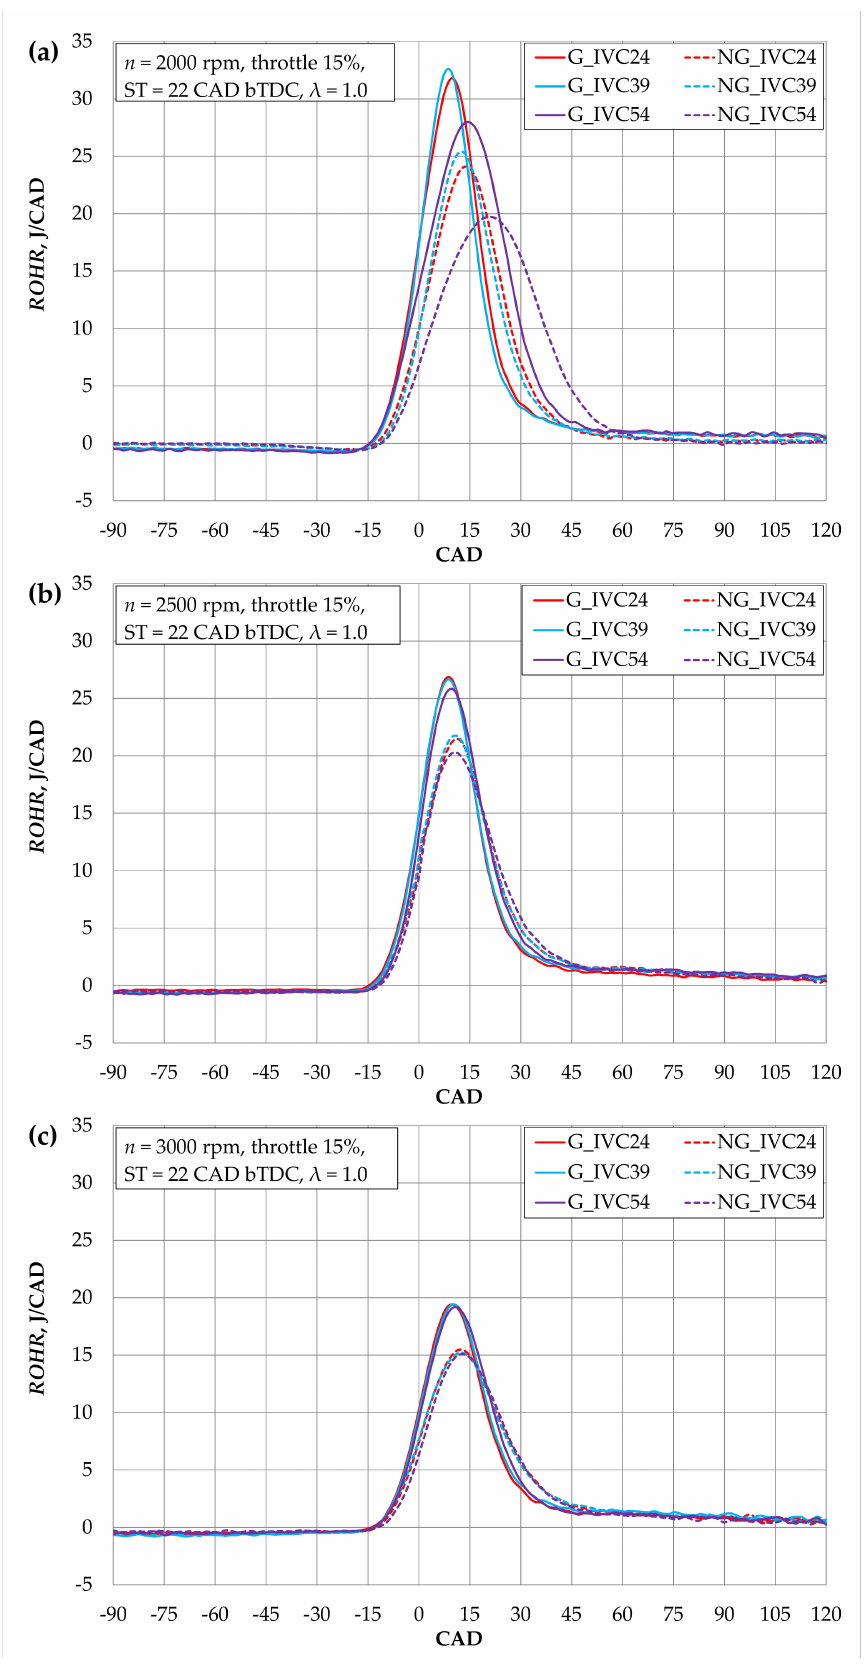
Figure 9. The rate of heat release when the engine is running on gasoline and natural gas and while changing the intake valve close timing: ( a ) 2000 rpm; ( b ) 2500 rpm; and ( c ) 3000